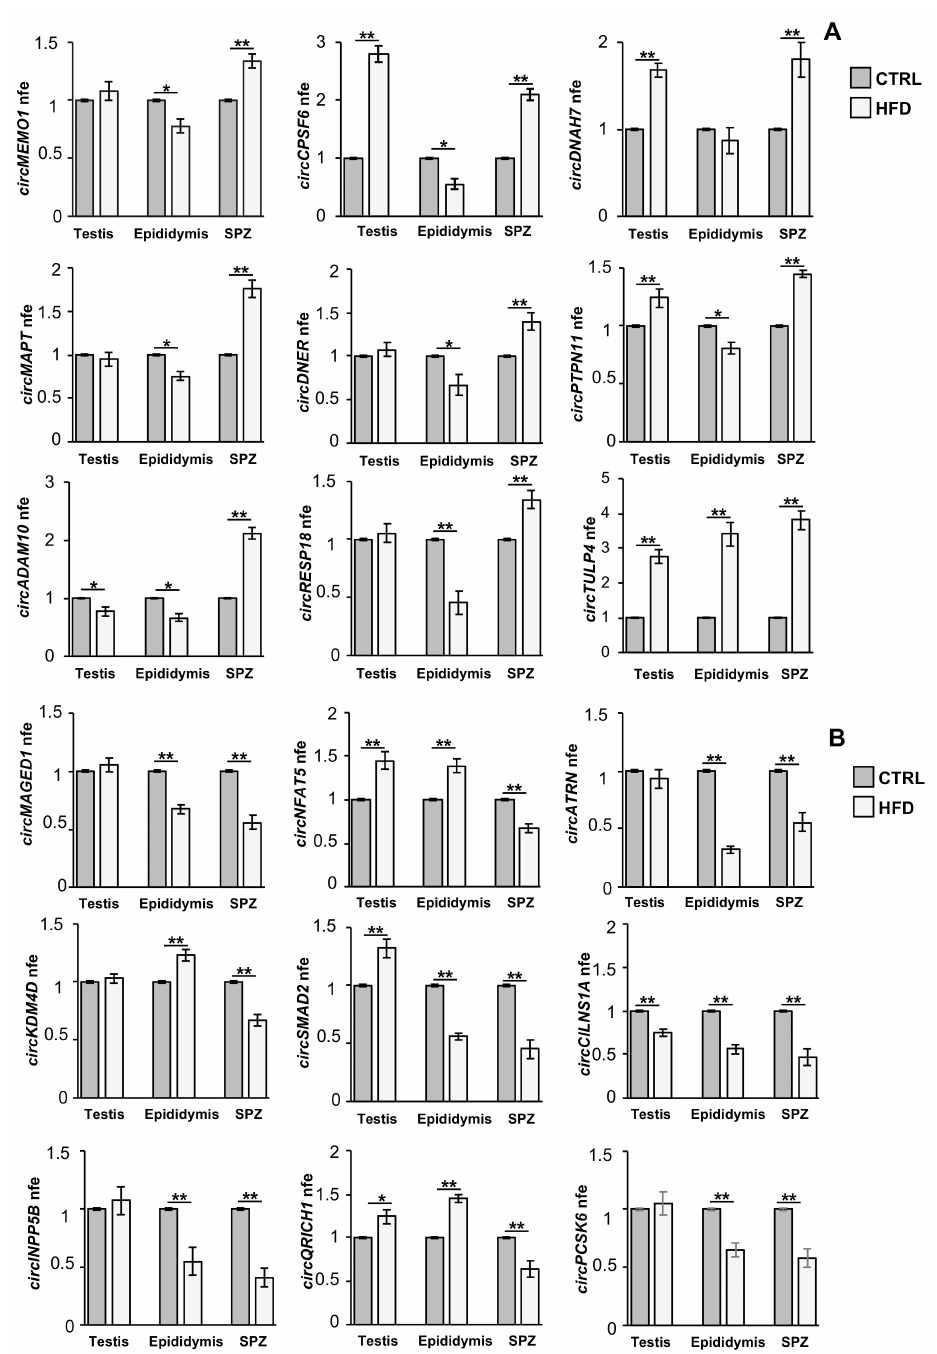
Figure 4. Validation of circRNA microarray results in testis, epididymis, and SPZ from CTRL and HFD mice. ( A ) Expression analysis of 9 circRNAs upregulated in HFD compared with CTRL-derived SPZ. ( B ) Expression analysis of 9 circRNAs downregulated in HFD compared with CTRL-derived SPZ. qRT-PCR data are normalized using cyclophilin and ribosomal protein S18 ( RPS18 ) for SPZ and tissues, respectively, expressed as fold expression (nfe) and reported as mean value ± S.E.M. **: p < 0.01; *: p <